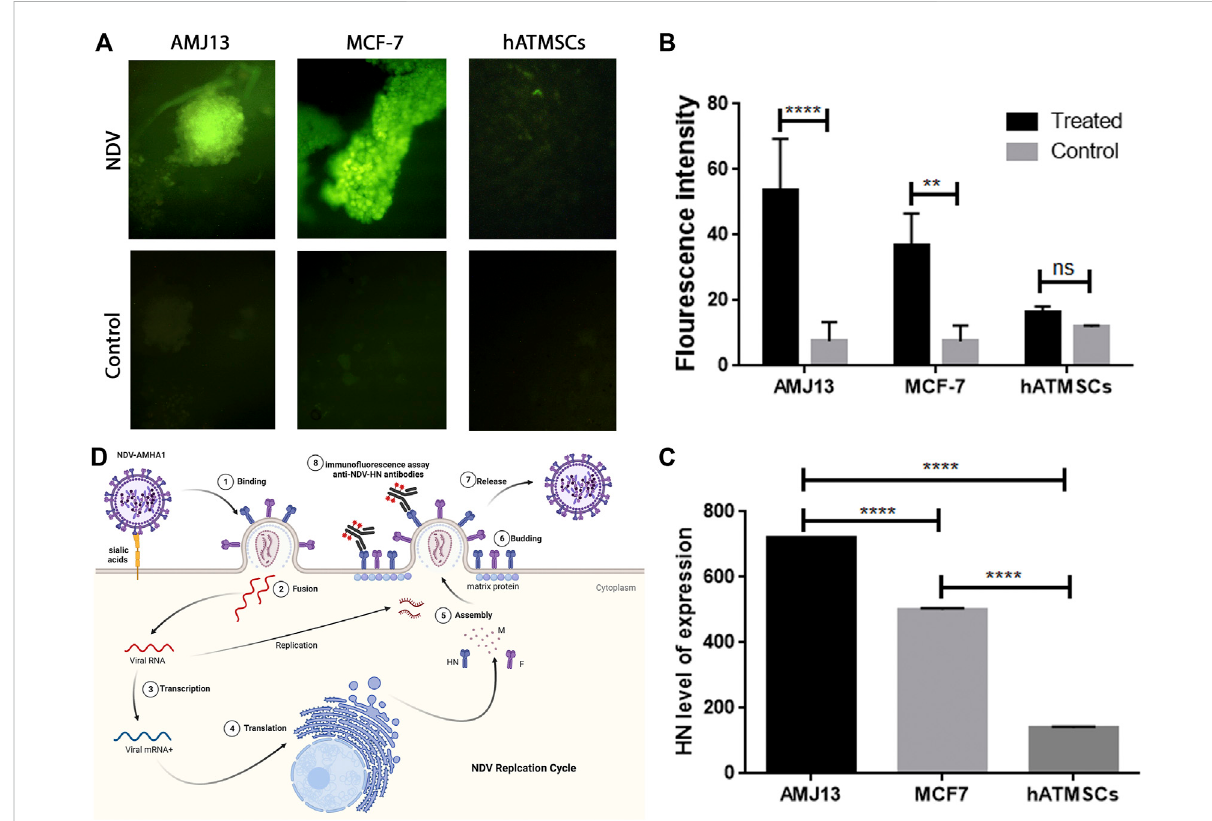
FIGURE 7 Immuno fl uorescence (IF) assay for NDV-HN protein detection con fi rms NDV AMHA1 infectivity and replication inside the spheroids through staining with anti-HN NDV mAbs. (A) Comparison between infected cells and the controls of all three spheroid types. Infected cancer spheroids expressing HN protein heavily, whereas there is no expression seen in the control or noninfected spheroids, while normal hATMSCs spheroids show low signal levels. (B) The fl uorescence intensity analysis for the expression of HN-NDV protein in NDV-infected cancer and normal spheroids and comparison of the levels of expression showing signi fi cant HN protein expression levels in infected cancer spheroids when compared to noninfectedcancerspheroids.Also,therewerenosigni fi cantHNproteinlevelsintheinfectednormalcellspheroidswhencomparedtononinfected normal spheroids. (C) Our fi ndings show signi fi cant expression levels of HN-NDV in cancer cell spheroids that are NDV treated when compared to theuntreatedcontrolcancerspheroids.Moreover,thereisasigni fi cantlyhigherexpressionofHN-NDVincancerspheroids(AMJ13andMCF7)when compared to normal cells (hATMSCs). These results have con fi rmed that NDV AMHA1 could infect and replicate ef fi ciently in cancer spheroids only with no signi fi cant replication in normal spheroids. (D) NDV AMHA1 replication cycle shows that HN protein is an important NDV protein inserted in the infected cell surface during the NDV replication cycle inside the cells. HN-NDV presence on the cell surface proves virus replication and